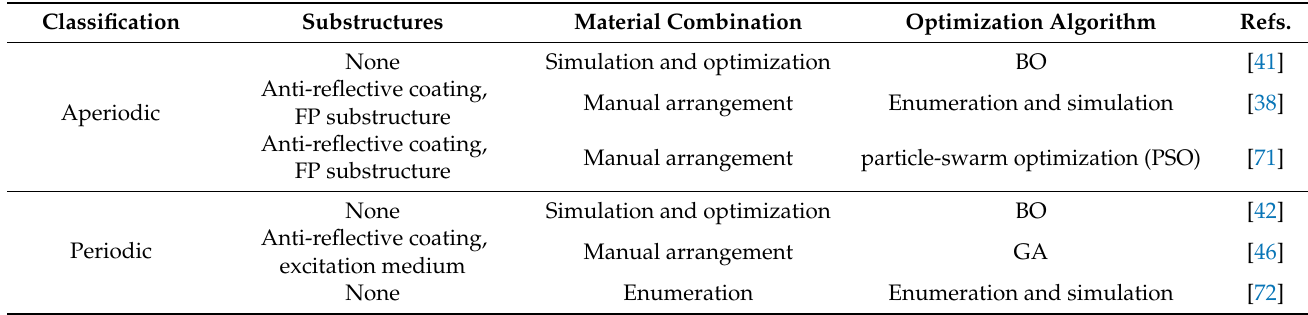
Table 2. Some previous studies of multilayer thermal emitters.